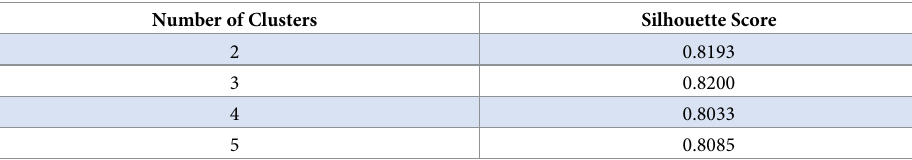
Table 5. The clustering effect of